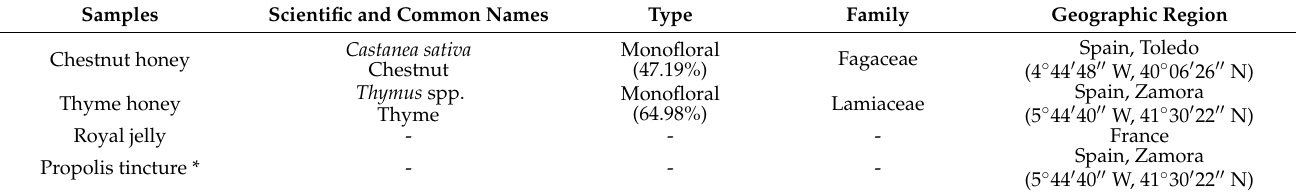
Table 1. Honey and bee product